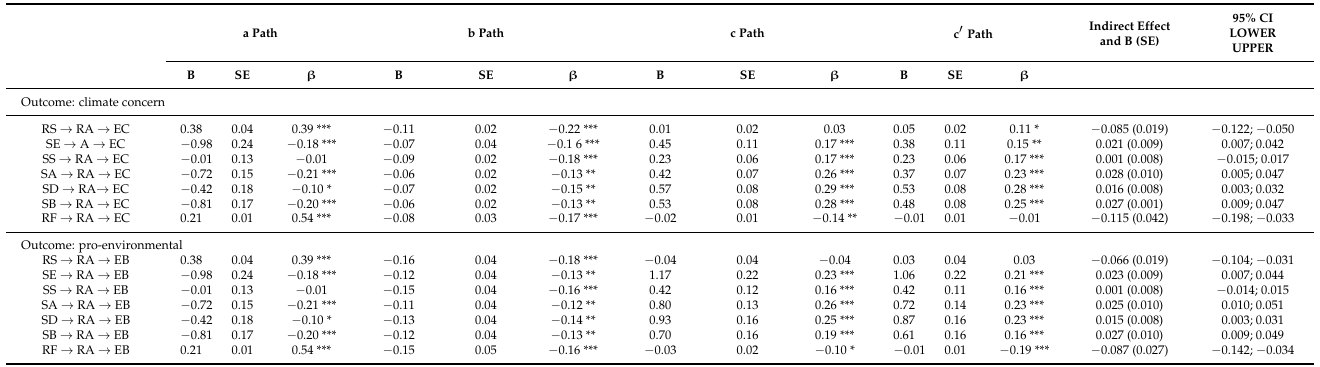
Table 3. The mediating role of right-wing authoritarianism in relationships between spiritual- ity/religious fundamentalism and ecological outcomes (N =